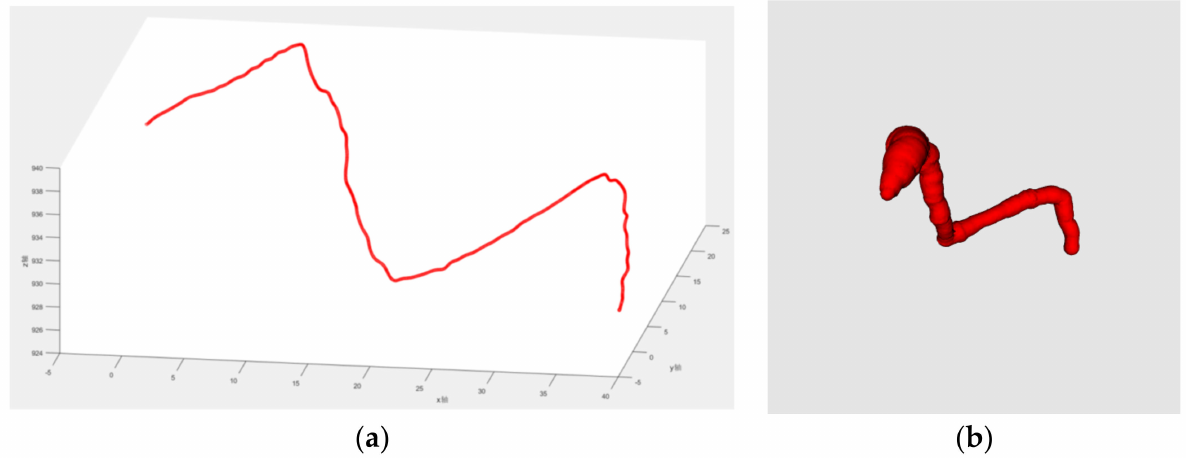
Figure 10. The result of the 3D reconstruction results is based on the proposed method. ( a ) is the reconstructed centerline; ( b ) is the reconstructed surface after head and tail